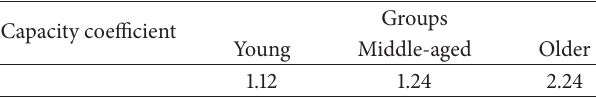
Table 2: Overall capacity coefficients for young, middle-aged, and older